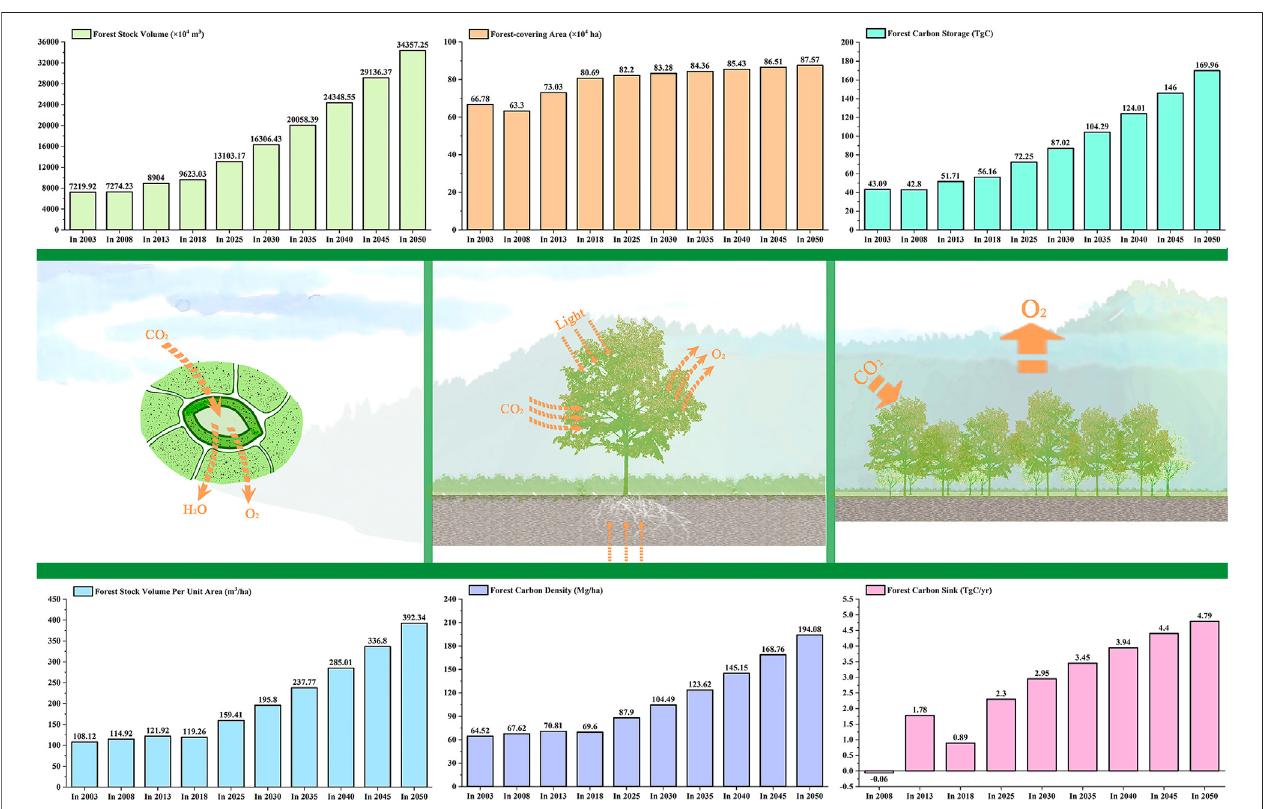
FIGURE 6 | Trends in the tropical forest growth in Hainan Island from 2003 to